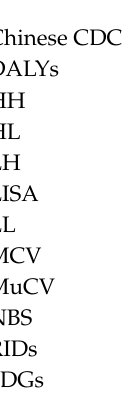
Table S1: The incidence of RIDs in each provincial unit during 2006–2016, Table S2: the number of cases and the incidence of RIDs by month. Table S3: Highlighted cells represent the months of infection peaks. Author Contributions: Y.M. and R.H. conceived and designed the study; R.H. and N.Z. collected and analyzed the data; R.H. and B.Z. drafted the paper; B.Z., J.L. and Y.M. read and revised the draft critically. All authors have read and agreed to the published version of the